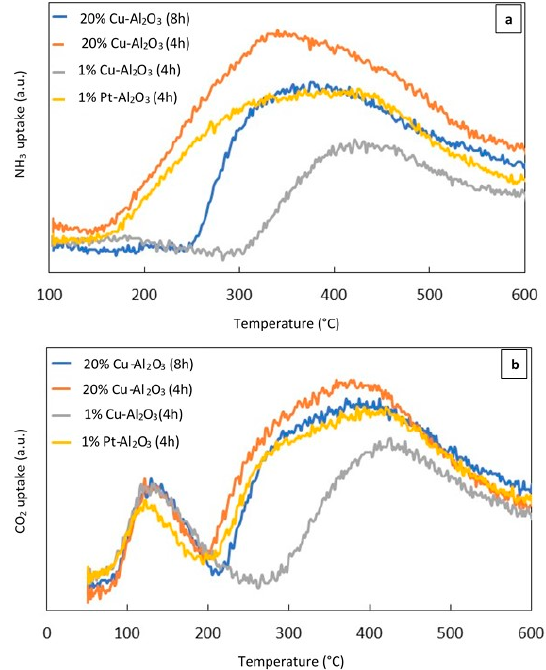
Figure 3. ( a ) (NH 3 –TPD) profiles of the different catalysts, ( b ) (CO 2 –TPD) profiles of the different